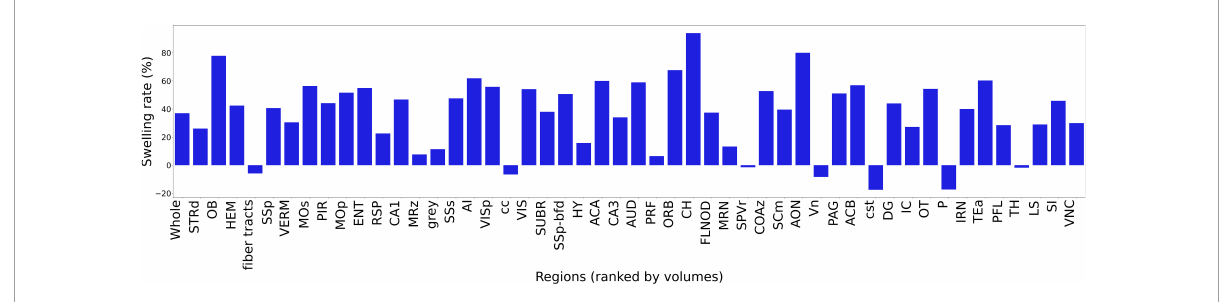
FIGURE6 Bar plot of ratio of the volume before and after registration. The regions are ranked by the ROI volume. The ratio is obtained by V before reg − V after reg V The abbreviations of the regions are based on rCCFv3 (Johnson et al., 2022) with a labeling convention consistent with